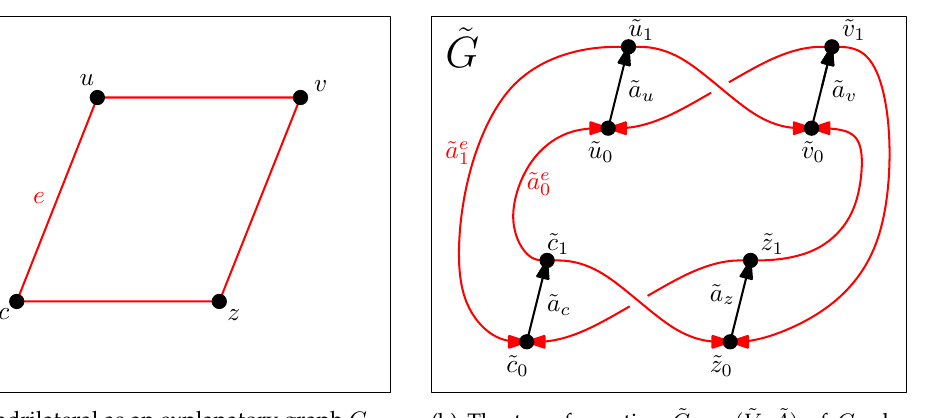
weight ( c, v ) -separator.